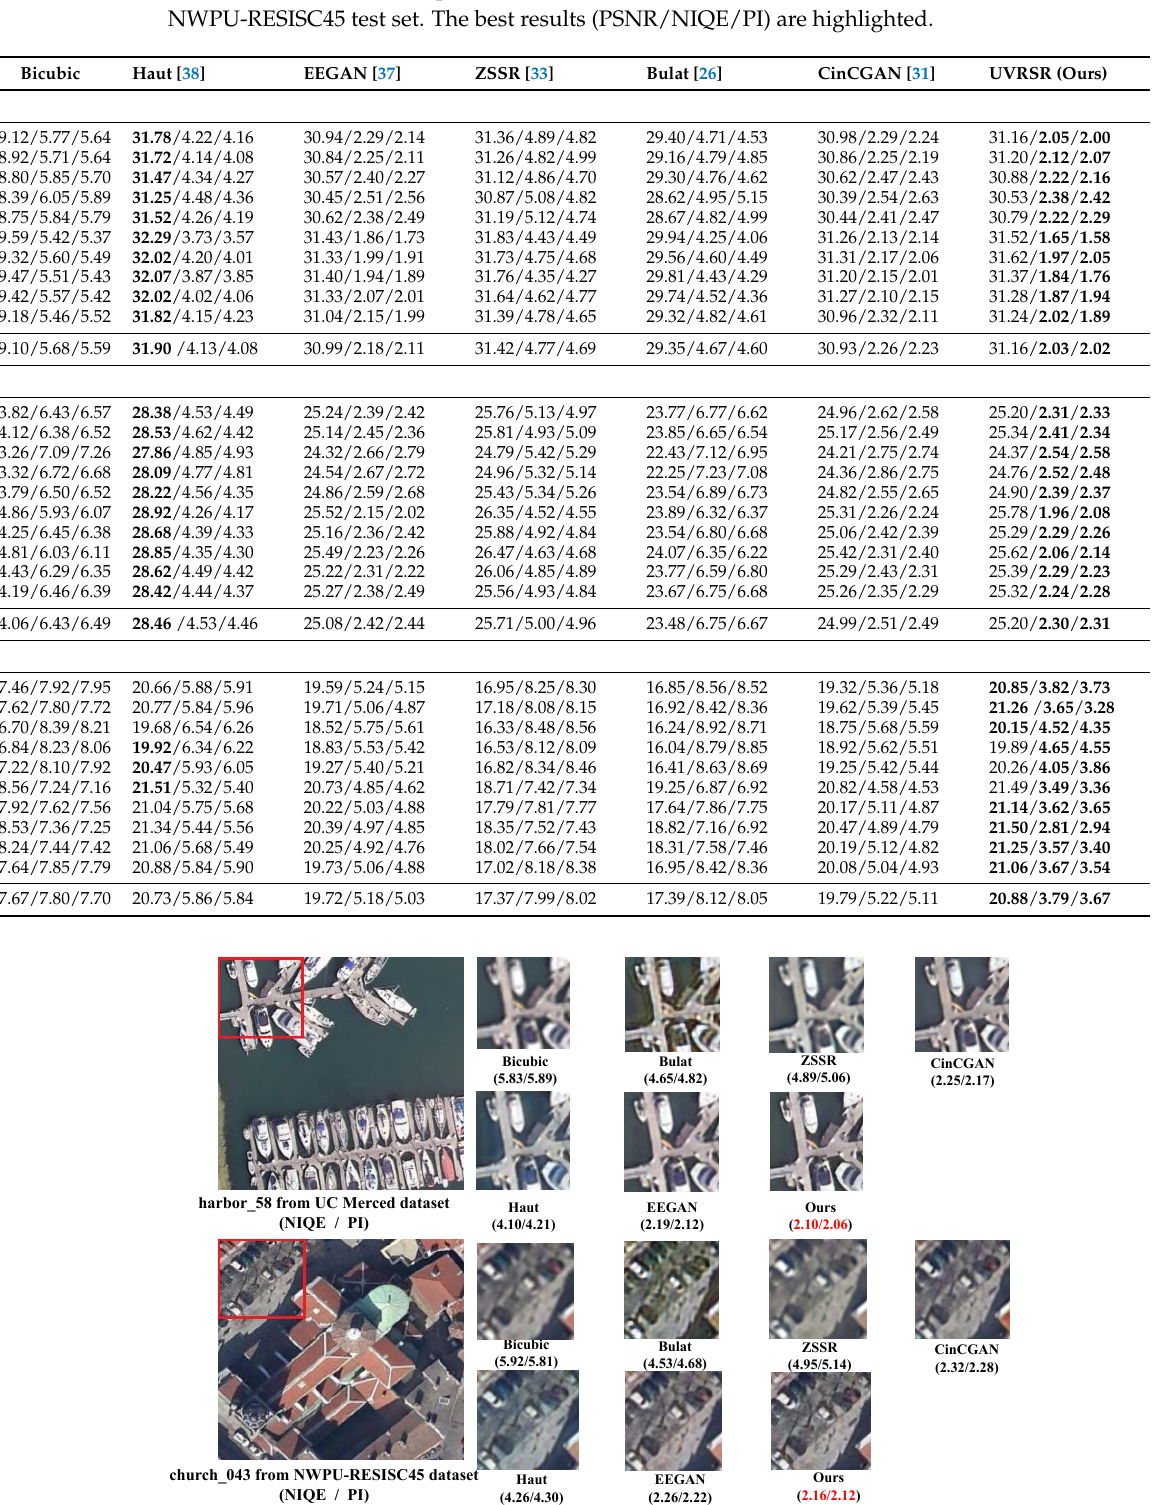
Figure 8. Visual comparison on two remote sensing datasets with the scale factor of 2 on the UC Merced dataset, see upper images, and for the NWPU-RESISC45 dataset, see lower images. The LR inputs and SR outputs in both cases are 200 the SR images for better comparison. We additionally compute the NIQE and PI for each ROI, which lower denote better quality. We can easily observe that UVRSR yields all comparable